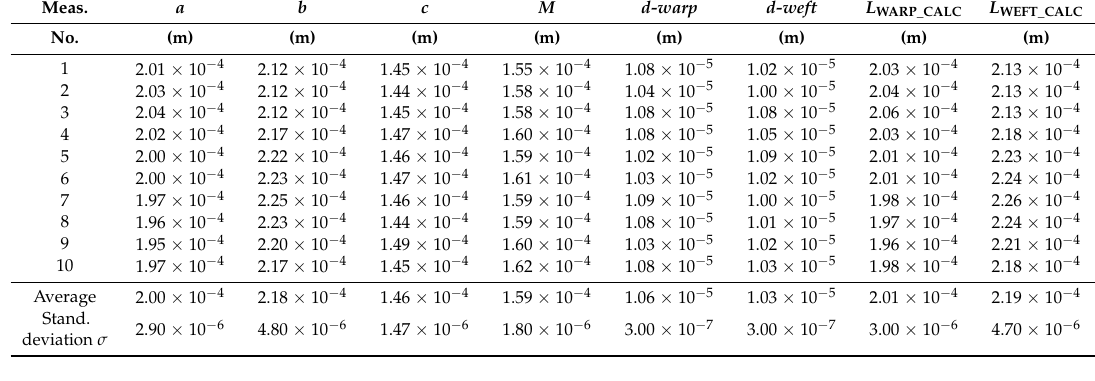
Table 5. The measurement results of input parameters a , b , c , M , d-warp , d-weft , L WARP_CALC , and L WEFT_CALC -RSKCuIv4. Meas.